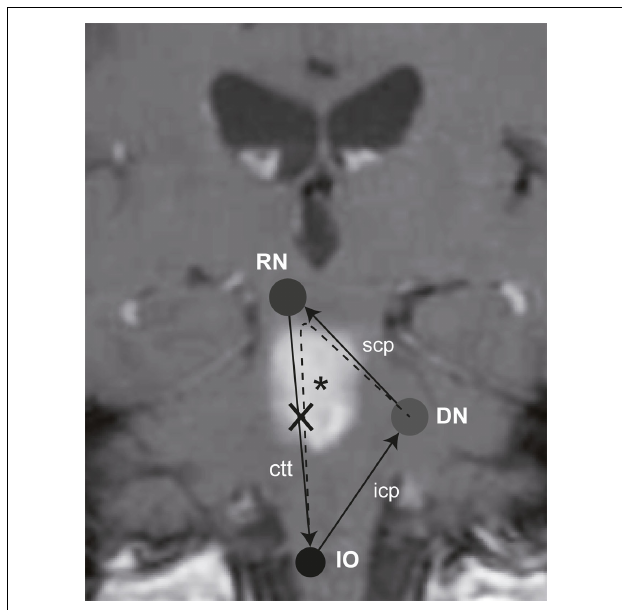
FIGURE 1 | Schematic illustration of the “Guillain–Mollaret triangle” projected on a coronal MR-image of the patient, showing the T1-hyperintense subacute ponto-mesencephalic hemorrhage ( ∗ ). It is also taken into consideration, that the red nucleus may rather be bypassed (Lapresle, 1979), resulting in a direct dentato-olivary pathway (dashed line). As a consequence the right central tegmental tract (ctt) is damaged, interrupting the connection between the red nucleus (RN) and the ION. Abbreviations: icp, inferior cerebellar peduncle; scp, superior cerebellar